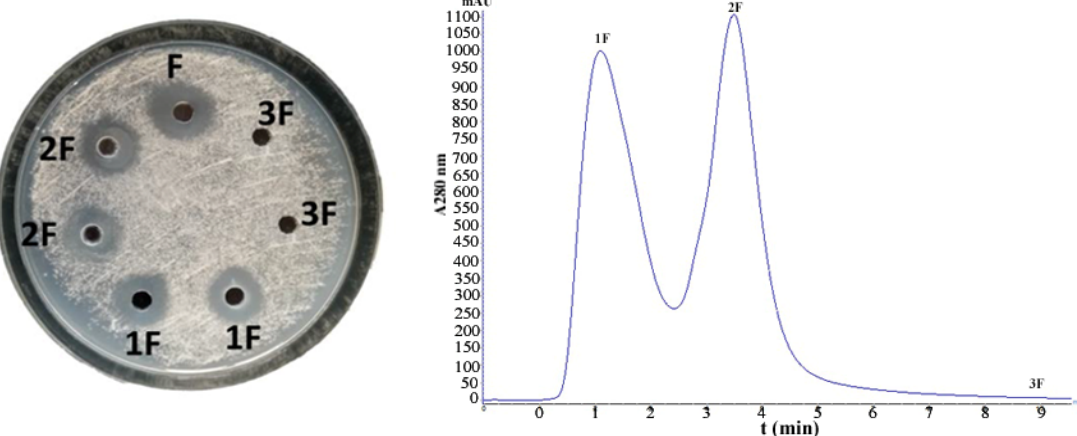
Figure 1. Desalting results of crude protein by Sephadex G-25 and antifungal effect of elution peak (Note: F for crude protein, 1F for peak 1, 2F for peak 2, 3F for peak (Note: F for crude protein, 1F for peak 1, 2F for peak 2, 3F for peak 3).